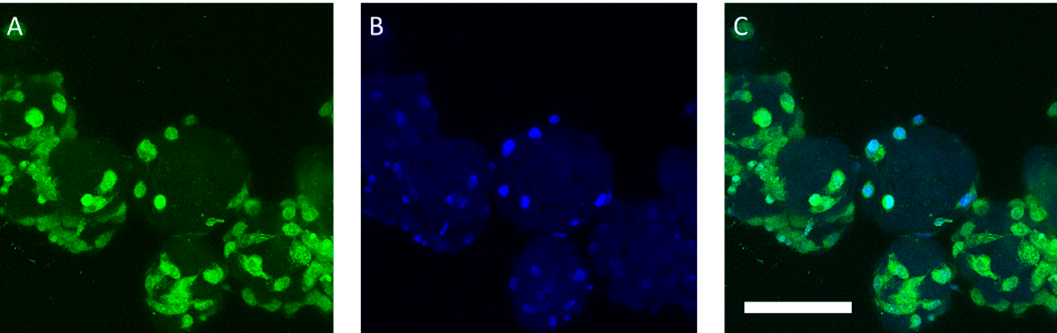
Figure 8. Confocal laser-scanning microscopy analysis of BR44 MCs after two days of culture. ( A ) The strong natural autofluorescence of the cells can be exploited to visualize the hASCs grown on the surface of the BR44 carrier. ( B ) The DAPI staining reveals the presence of several nuclei on the surface of BR44 . ( C ) Merged. Magnification 400×, scale bar 100 µm. Table 3. Analysis of the nuclei by flow cytometry. The nuclei can be divided into three groups based on different DNA amount. The three phases of interest, G1, G2, and S, are distinguishable (see Supplementary Material Figures S8 and S9). The data are shown for the four measurements (day 1, 3, 6, and 8). The table shows the number and percentages of nuclei found in G1, G2, or S phase for ASC52telo grown on BR44 . The active proliferation percentage (APP) was calculated as follows: APP = ((G2 + S)/G1) × 100.